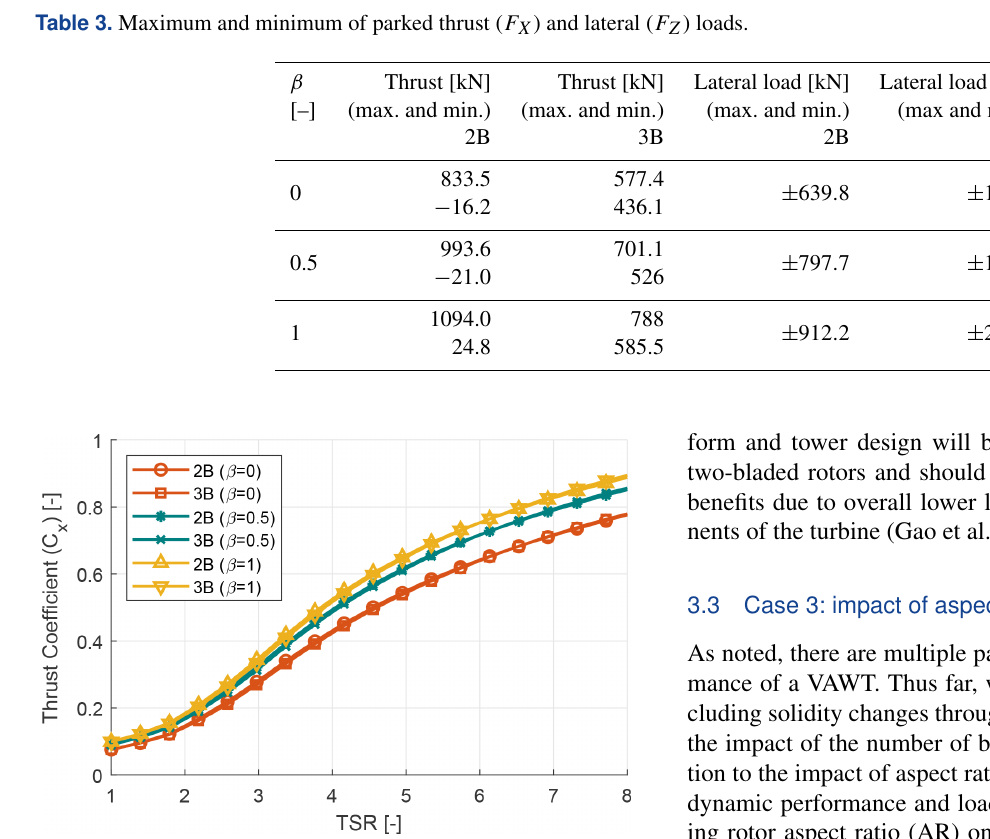
Figure 15. Rotor thrust coefficient ( C X ) analysis for two-bladed (2B) and three-bladed (3B)